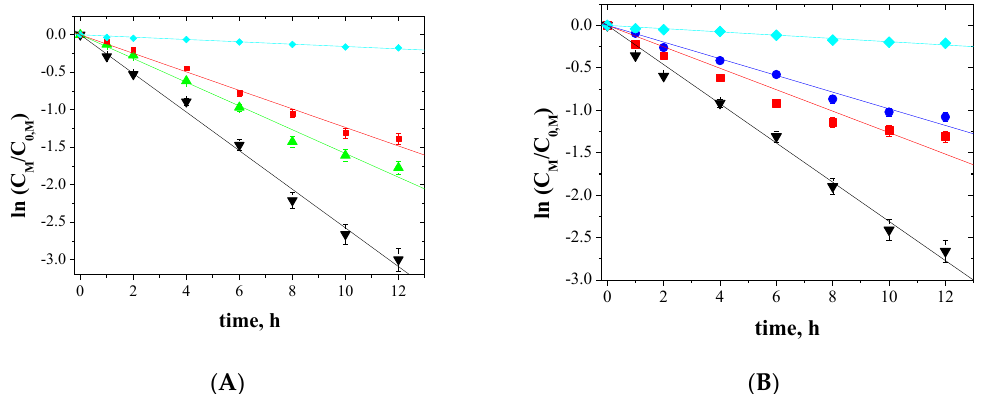
Figure 6. Kinetics of the transport across PIMs containing EDAB-acac for 4-component mixture of ▼ -Zn(II), ▲ -Cd(II), -Co(II), and -Ni(II) ( A ); ▼ -Zn(II), -Co(II), -Cu(II), and -Ni(II) ( B ).